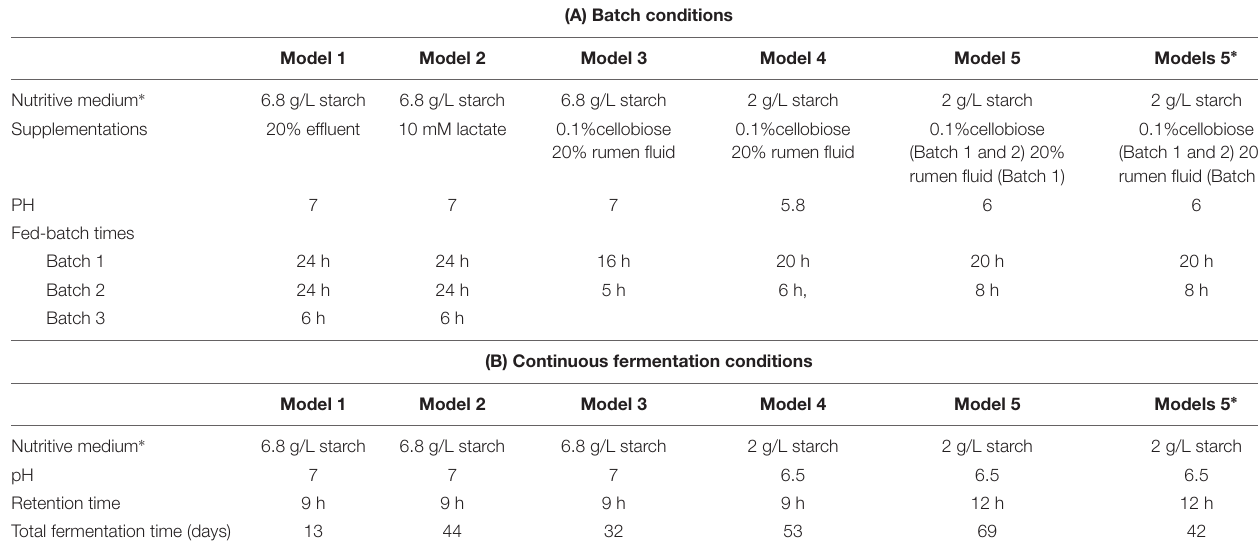
TABLE 1 | Conditions of initial batch (bead colonization) (A) and continuous (B) fermentation for the different tested models of mouse caecal